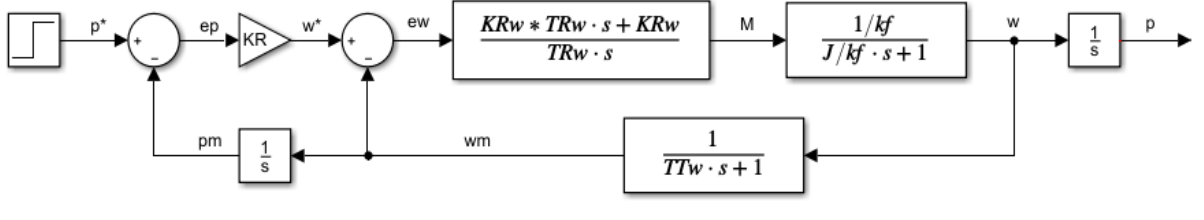
Figure 2. Block diagram of the linear control